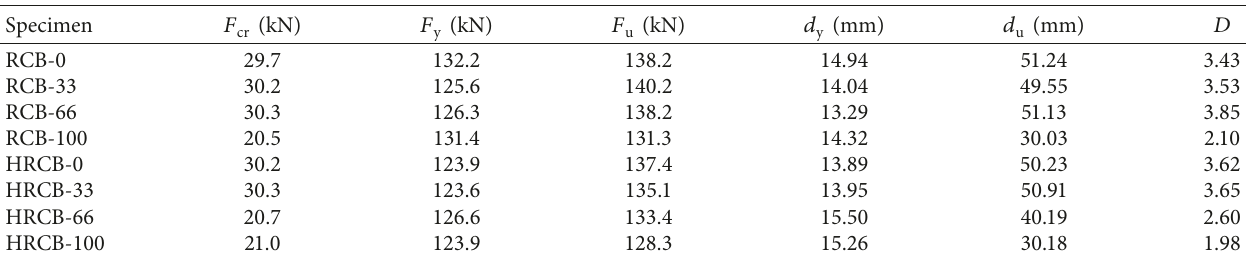
Table 4: Results of the loading